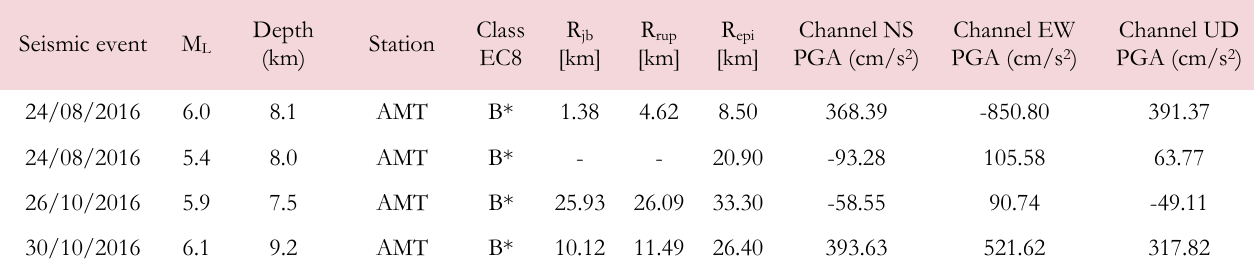
Table 2: Characteristics of main earthquakes recorded in Amatrice (AMT) station during the main shocks of the Central Italy seismic sequence of 2016, where * indicates that site classification is not based on a direct Vs,30 measurement